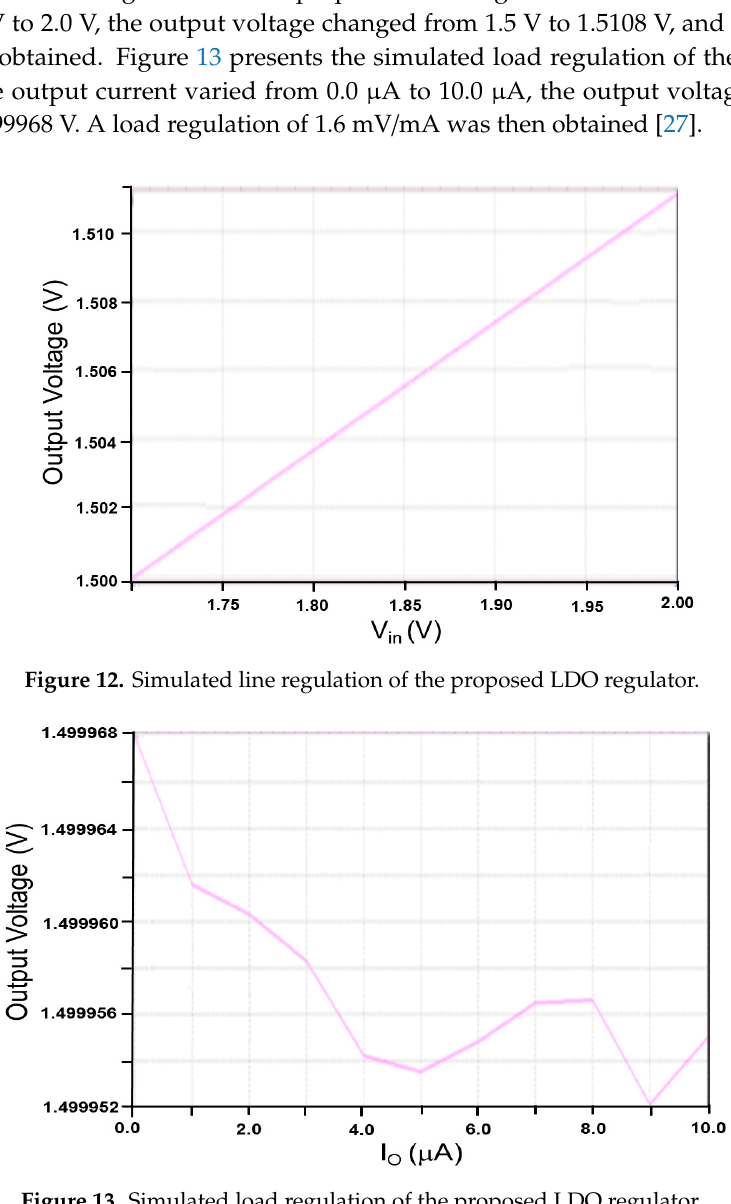
Figure 13. Simulated load regulation of the proposed LDO regulator.